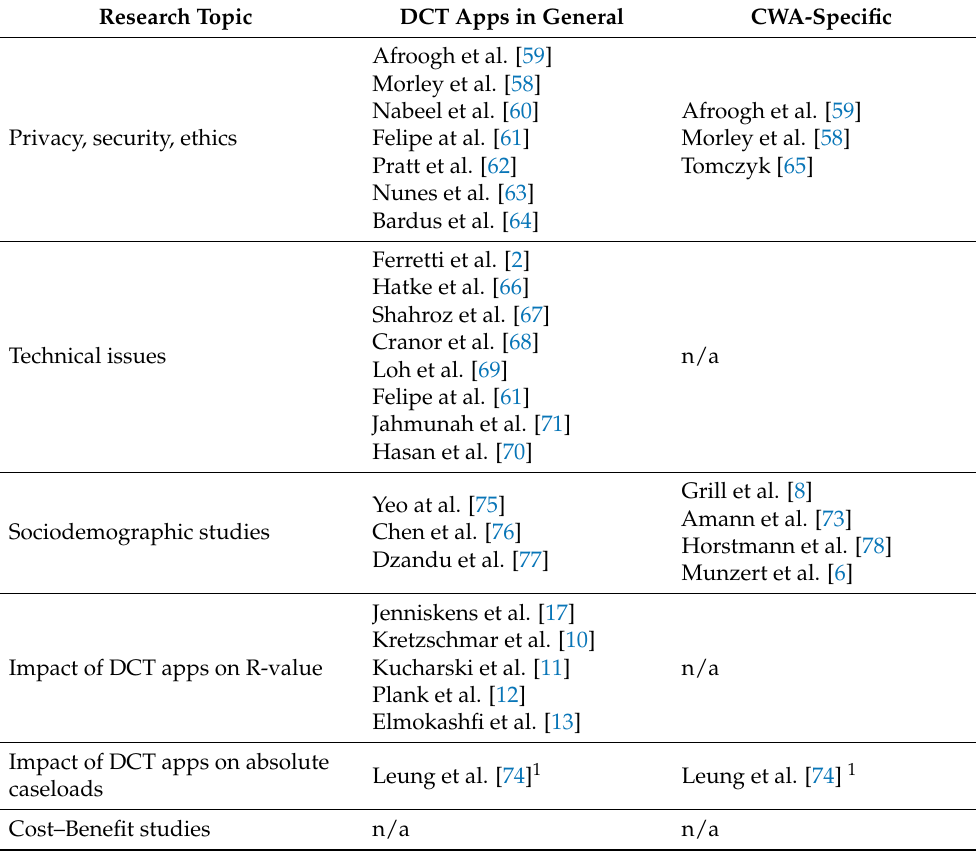
Table 3. Overview of related work on DCT apps in general and the CWA in